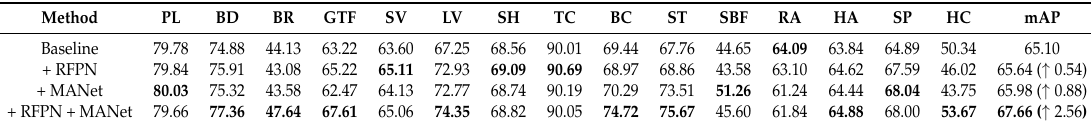
Table 5. Results of ablative study of different component in RADet. The +RFPN means that we replace the FPN in baseline with our proposed Refine Feature Pyramid Network, and +MANet means that we add our proposed Multi-layer Attention Network to baseline. The short names here are the same as that in Table 2. Bold numbers in Tables means the best